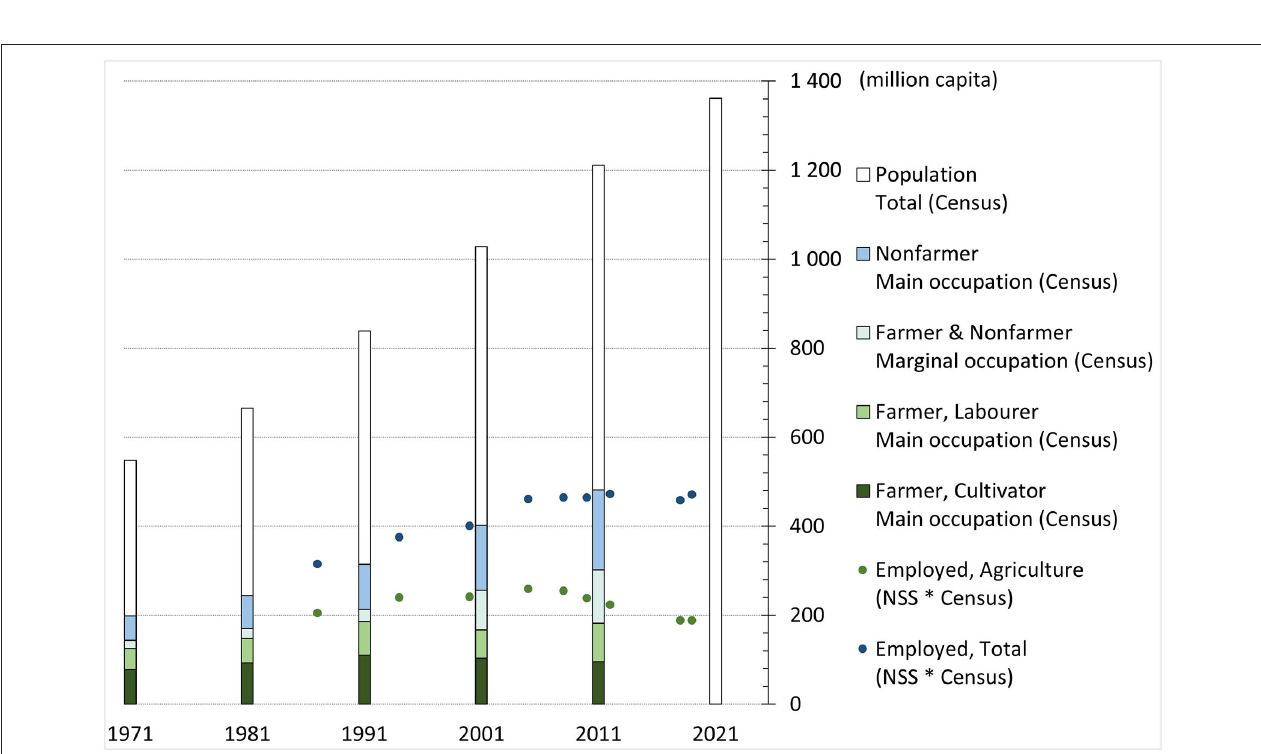
FIGURE 3 | Population and composition of the labor force: Census of India and NSS (1971–2019). Source: B. Dorin, estimated from data/reports published by the Censuses of India and the National Sample Surveys. Note: after 2011, total population based on Samir et al. (2018)’s projections.